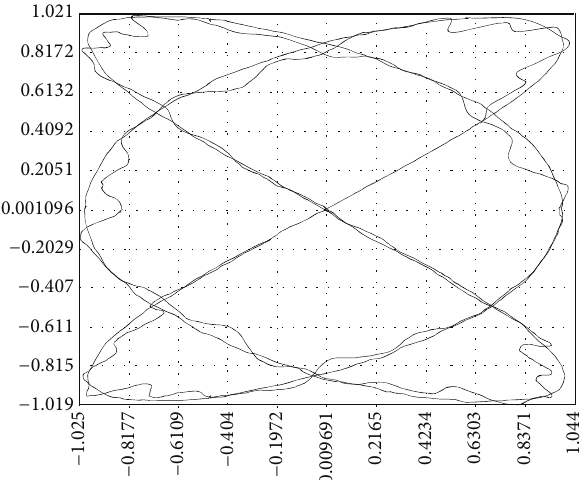
Figure 6: Approximation of vector-function g (𝑡) = ( cos (1.5𝑡), sin (𝑡)) by fractal interpolation function g ⋆ .